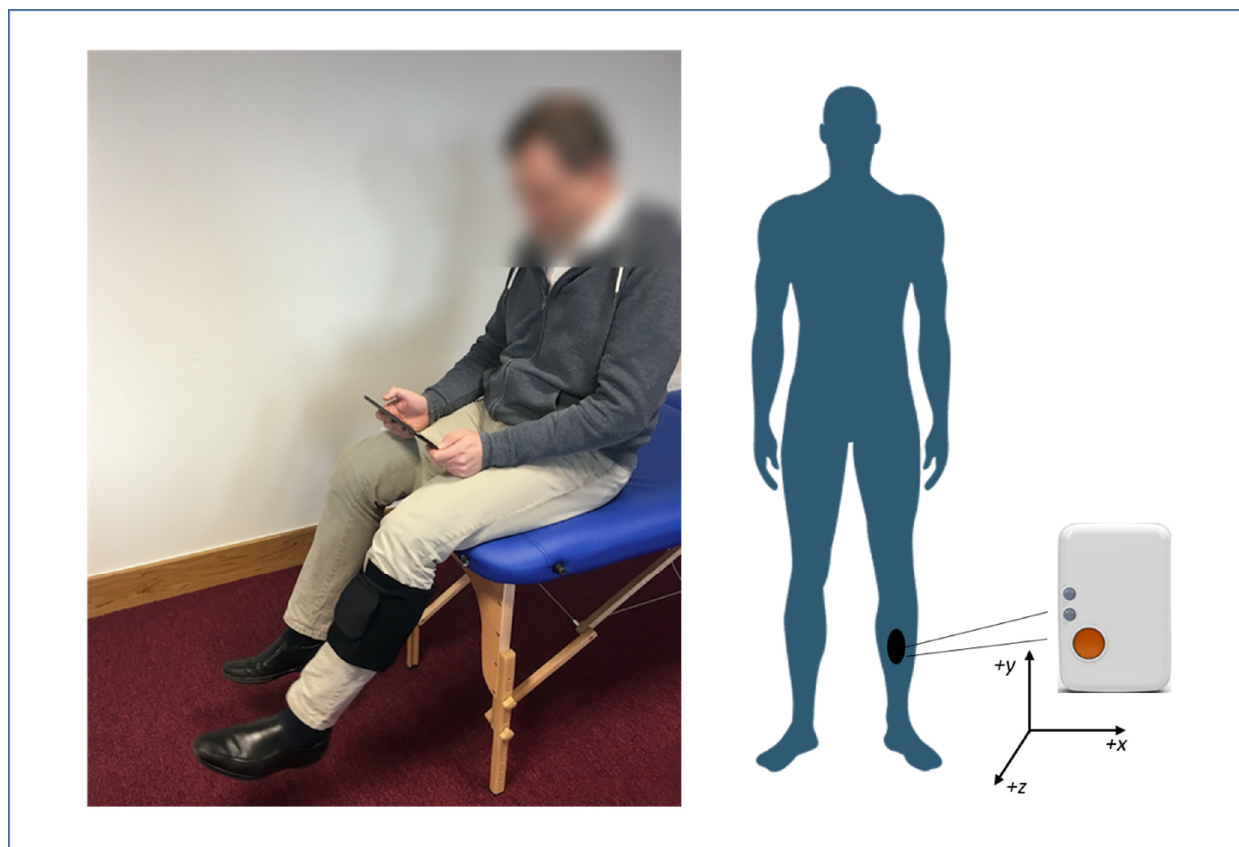
Figure 4. Illustration of IMU placement, orientation and user setup. Figure taken from Argent et al. (2019) [6].